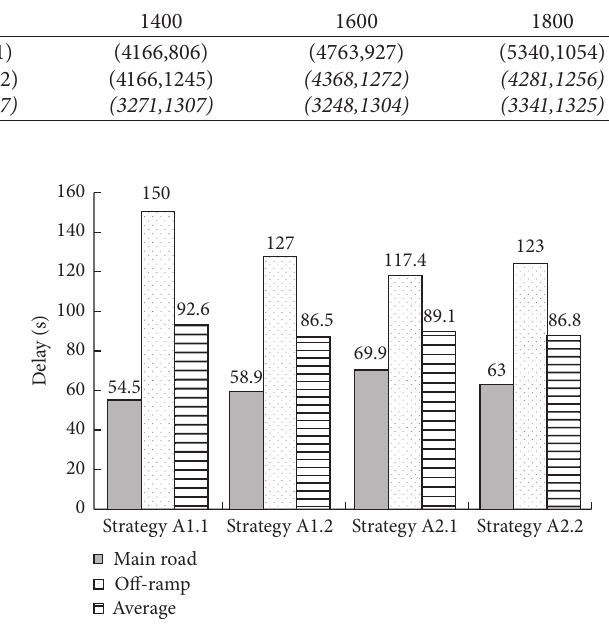
Figure 10: Vehicle delays comparison with main road flow 1200veh/h/lane and off-ramp rate